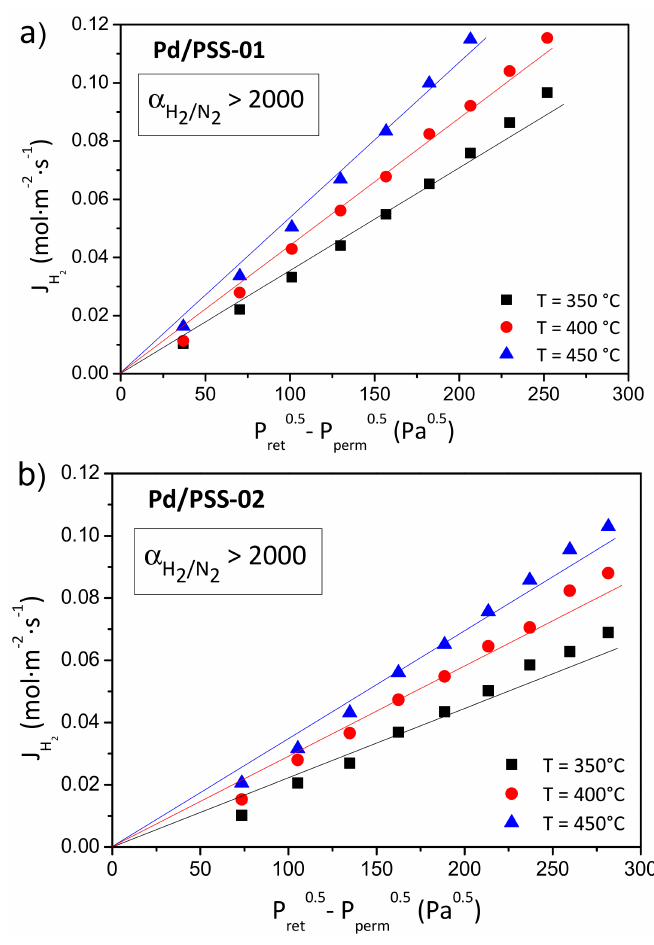
Figure 6. Permeation behavior of Pd-composite membranes prepared by ELP-PP over modified PSS supports with media grade 0.1 µ m ( a ) and 0.2 µ m ( b